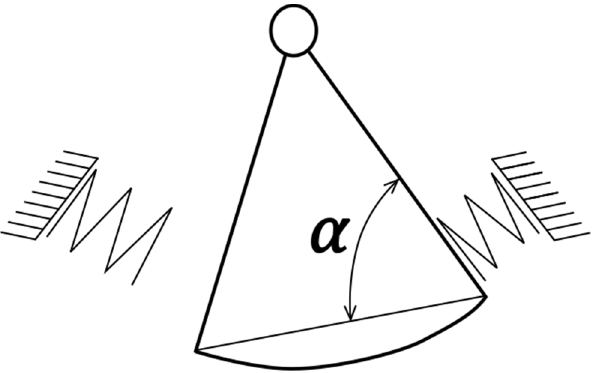
Figure 2. Analogy of the mechanical oscillator flowmeter to a compound pendulum; base angle α of the prismatic oscillator is marked.